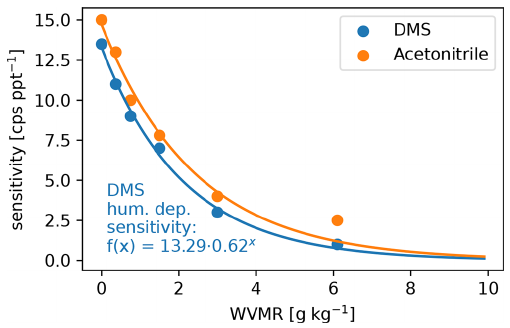
Figure C2. Water vapor mixing ratio (WVMR) dependent calibra- tion of DMS after the campaign together with the reference acetoni- trile that we calibrated regularly during the campaign. The DMS calibration data points are fitted with an exponential decay function (shown) that we used to calibrate the DMS